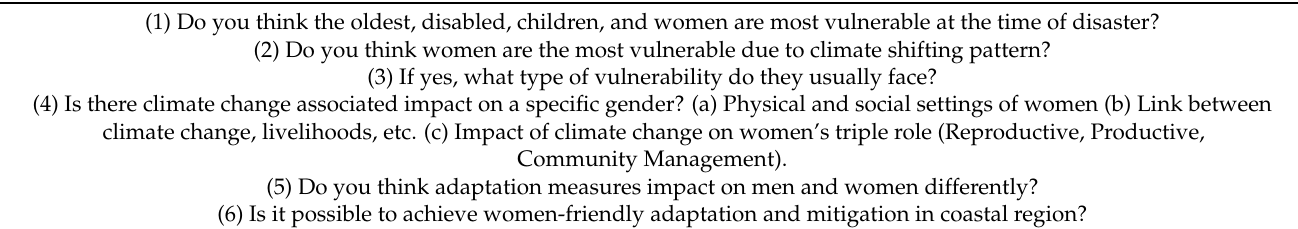
Table 2. Gender and climate change analysis